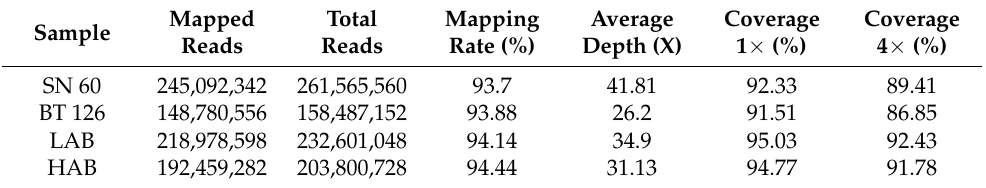
Table 1. Whole-genome mapping statistics for parents, as well as LAB and HAB bulks.